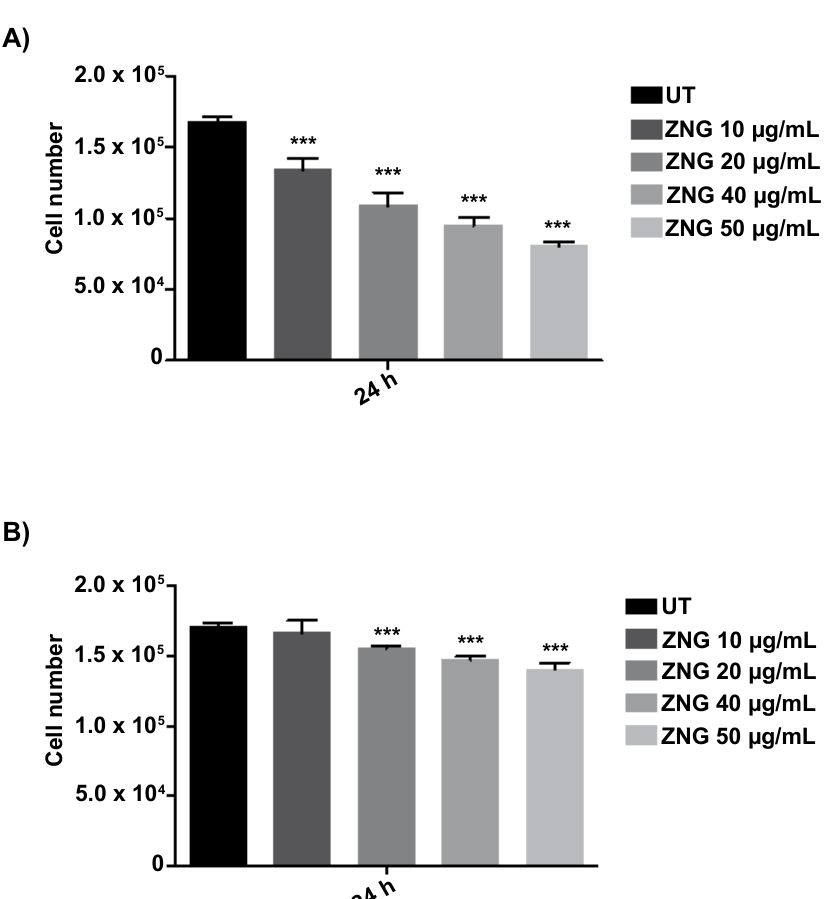
Figure 6. Cell viability of HaCaT cells after treatment with ZNGs suspended in ( A ) Dulbecco’s Modified Eagle’s Medium (DMEM) or ( B ) 4% glycerol in DMEM. The cell count was performed by the Trypan Blue dye exclusion test, and the values were reported as total number of living cells. Data are expressed as mean ± SD, n = 3. Statistical analysis was performed by one-way analysis of variance (ANOVA) method coupled with the Bonferroni post-test (*** p < 0.001 compared to the untreated sample (UT)).